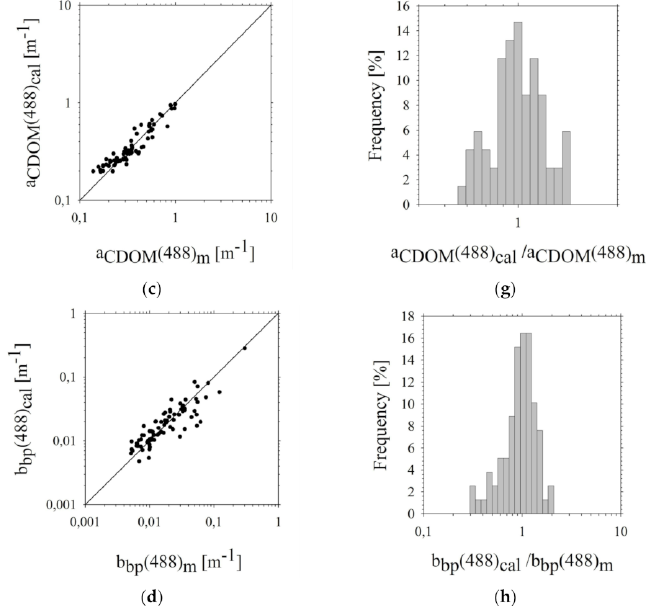
Figure 5. Comparison of: a ph ( λ i ), a d ( λ i ), a CDOM ( λ i ) and b bp ( λ i ) measured ( X ( λ i ) m ) and calcu- lated ( X ( λ i ) cal ) ( a – d ) using algorithms: ( a ) Equation (8), ( b ) Equation (12), ( c ) Equation (20) and ( d ) Equation (16) for a single wavelength (488 nm)-in the chosen areas of the southern Baltic. The solid line represents the function ( X ( λ i ) m = X ( λ i ) cal ). The probability density distribution of the ratio of calculated ( X ( λ i ) cal ) to measured ( X ( λ i ) m ) light absorption and backscattering coefficients ( e – h ) for wavelength 488 nm. Table 1. The relative errors in the